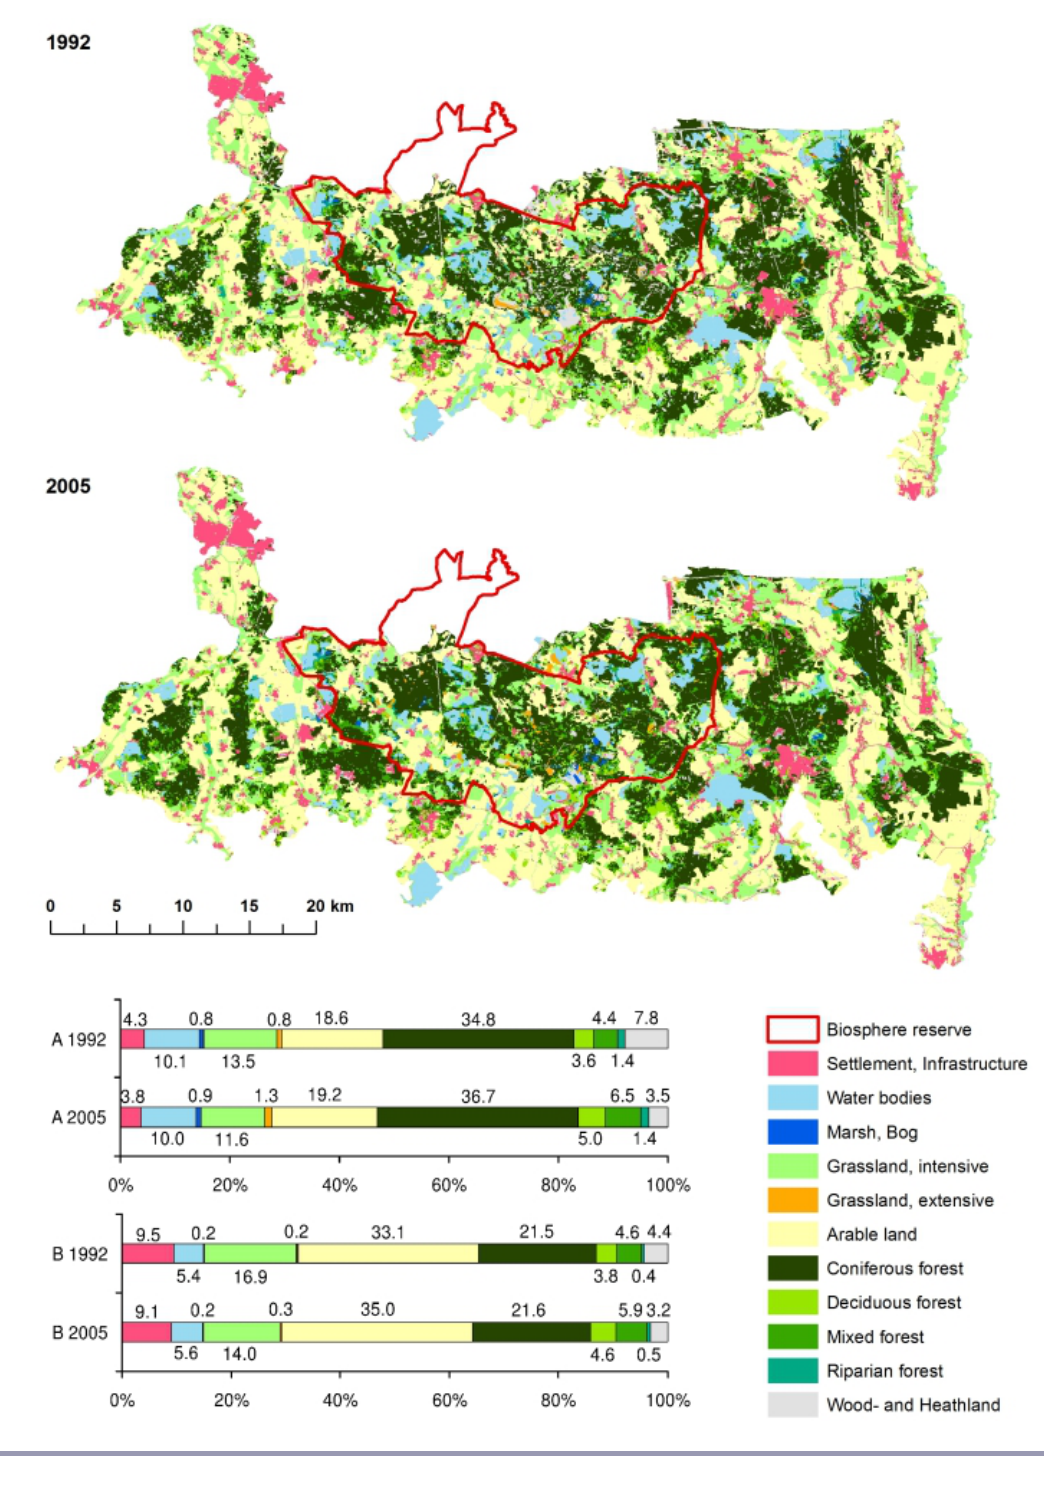
Fig. 2 . Land cover pattern in 1992 and 2005 and percentages of land cover classes in (A) the biosphere reserve and (B) the reference